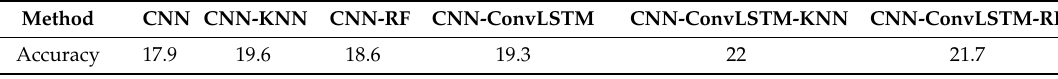
Table 6. Accuracy of the schemes when classifying the five subjects.